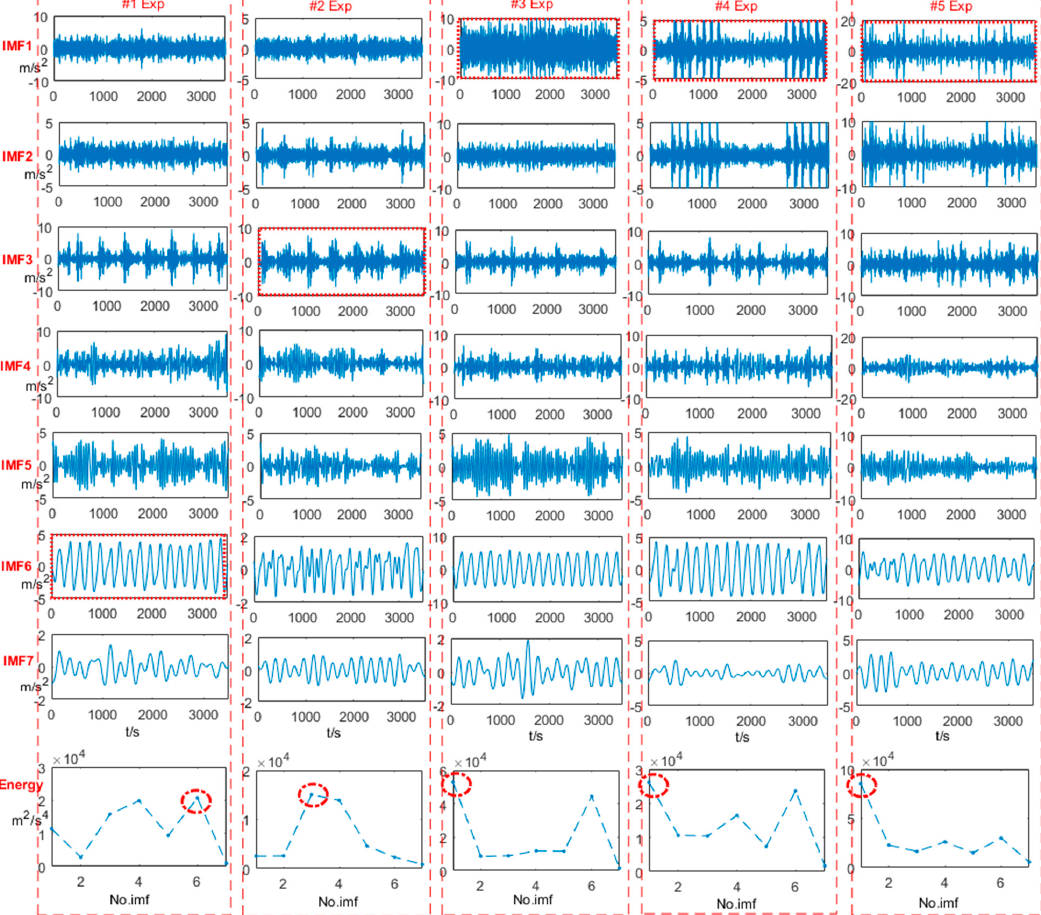
Figure 8. IMFs through EEMD and their energy distributions of vibration signals shown in Figure 7 (#1: a Figure 8. IMFs of vibration signals in Figure 7 obtained by using EEMD and their energy distributions normal bearing; #2: a bearing with an outer race defect; #3: a bearing with a pin roller defect; #4: a bearing (#1: a normal bearing; #2: a bearing with outer race defects; #3: a bearing with a pin roller defect; #4: a bearing with a cage defect; #5: a bearing with three kinds of coupling with a cage defect; #5: a bearing with three kinds of coupling defects)